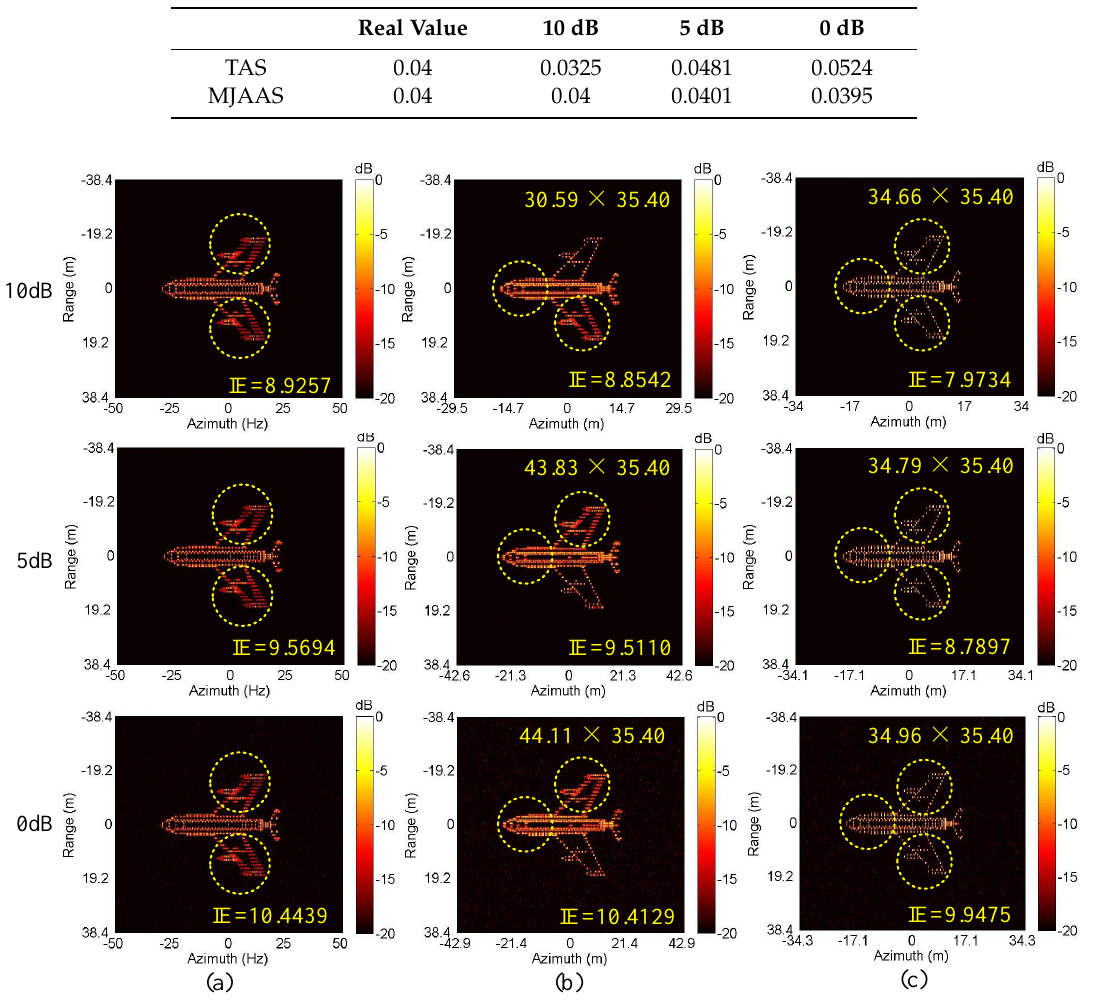
Figure 5. The imaging results of di ff erent algorithms at di ff erent SNRs corresponding to CM. ( a ) IMCM-PGA. ( b ) IMCM-PGA-TAS. ( c )